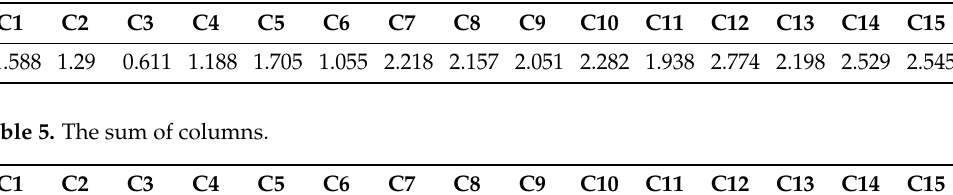
Table 4. The sum of rows.